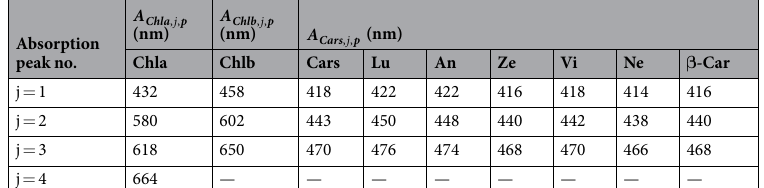
— — — — — — — — Table 4. The number of absorption peaks and their wavelength positions in the 400–800 nm region, for pure pigments in a mixed organic solution. Note that the absorption peak positions for Cars are based on the average positions of Lu, An, Ze, Vi, Ne and β -Car which were spectrally